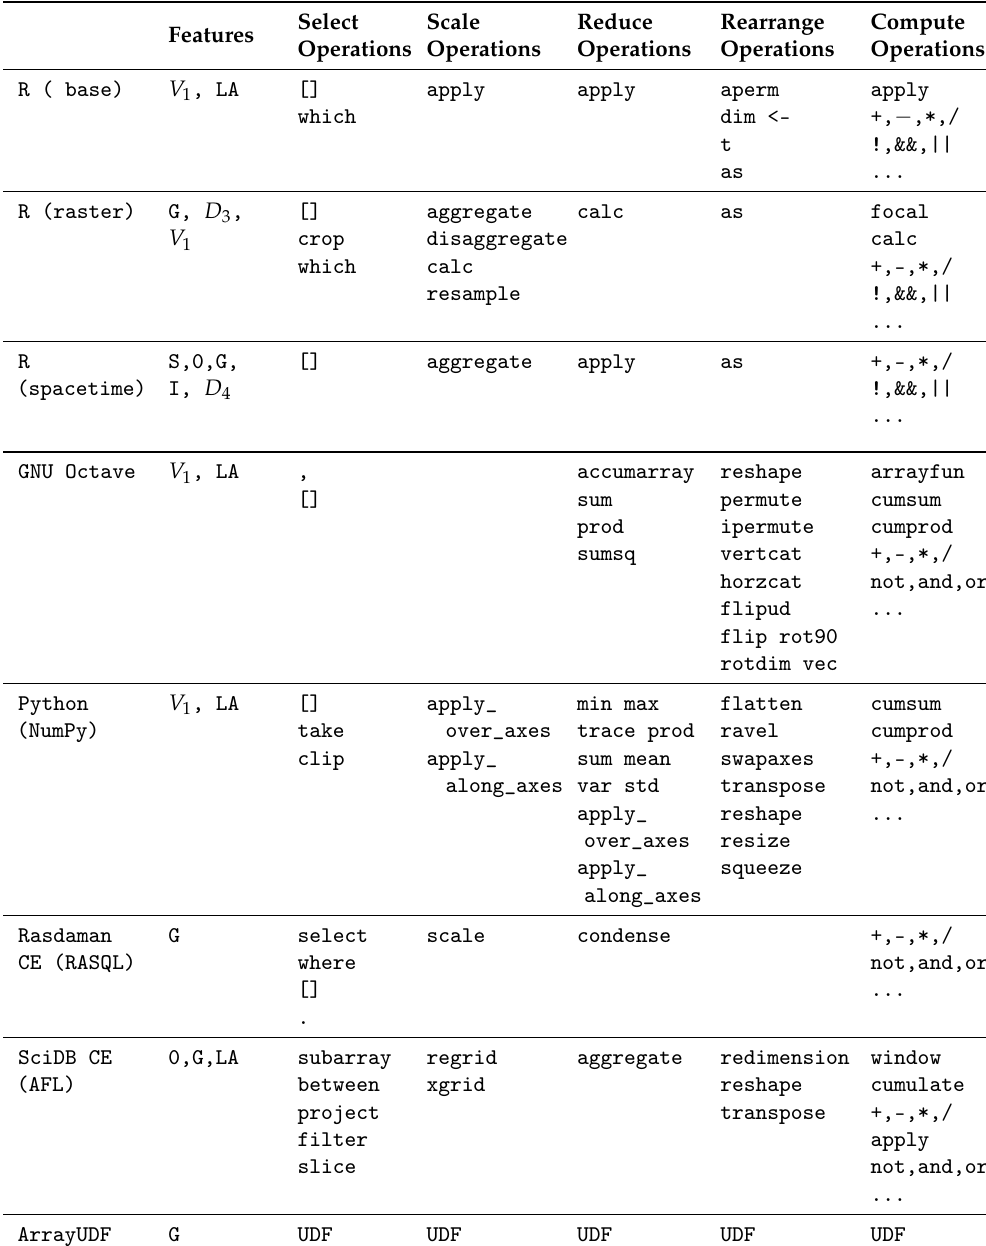
Table 1. Comparison of natively supported array operations in open-source data analysis software. UDF indicates user defined functions. Support of specific features is encoded as single letters where: 0 and I indicate support of sparse storage and irregular array dimensions respectively, G denotes whether geographic dimensions (space, time) are handled explicitly, and S represents whether the support of cells is considered appropriately. D n and V m are the maximum number of dimensions and attributes with n and m the limits, absence indicates no limits. LA indicates that linear algebra routines for vectors and matrices are